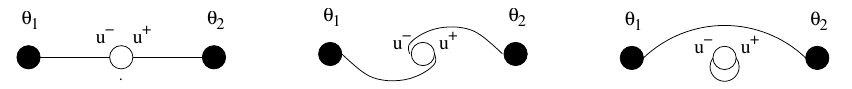
Figure 4 . O ( (cid:18) 1 ; (cid:18) 2 ; u + ; u (cid:0) ) in graphical notation. The (cid:12)rst two diagrams are connected, while the last is